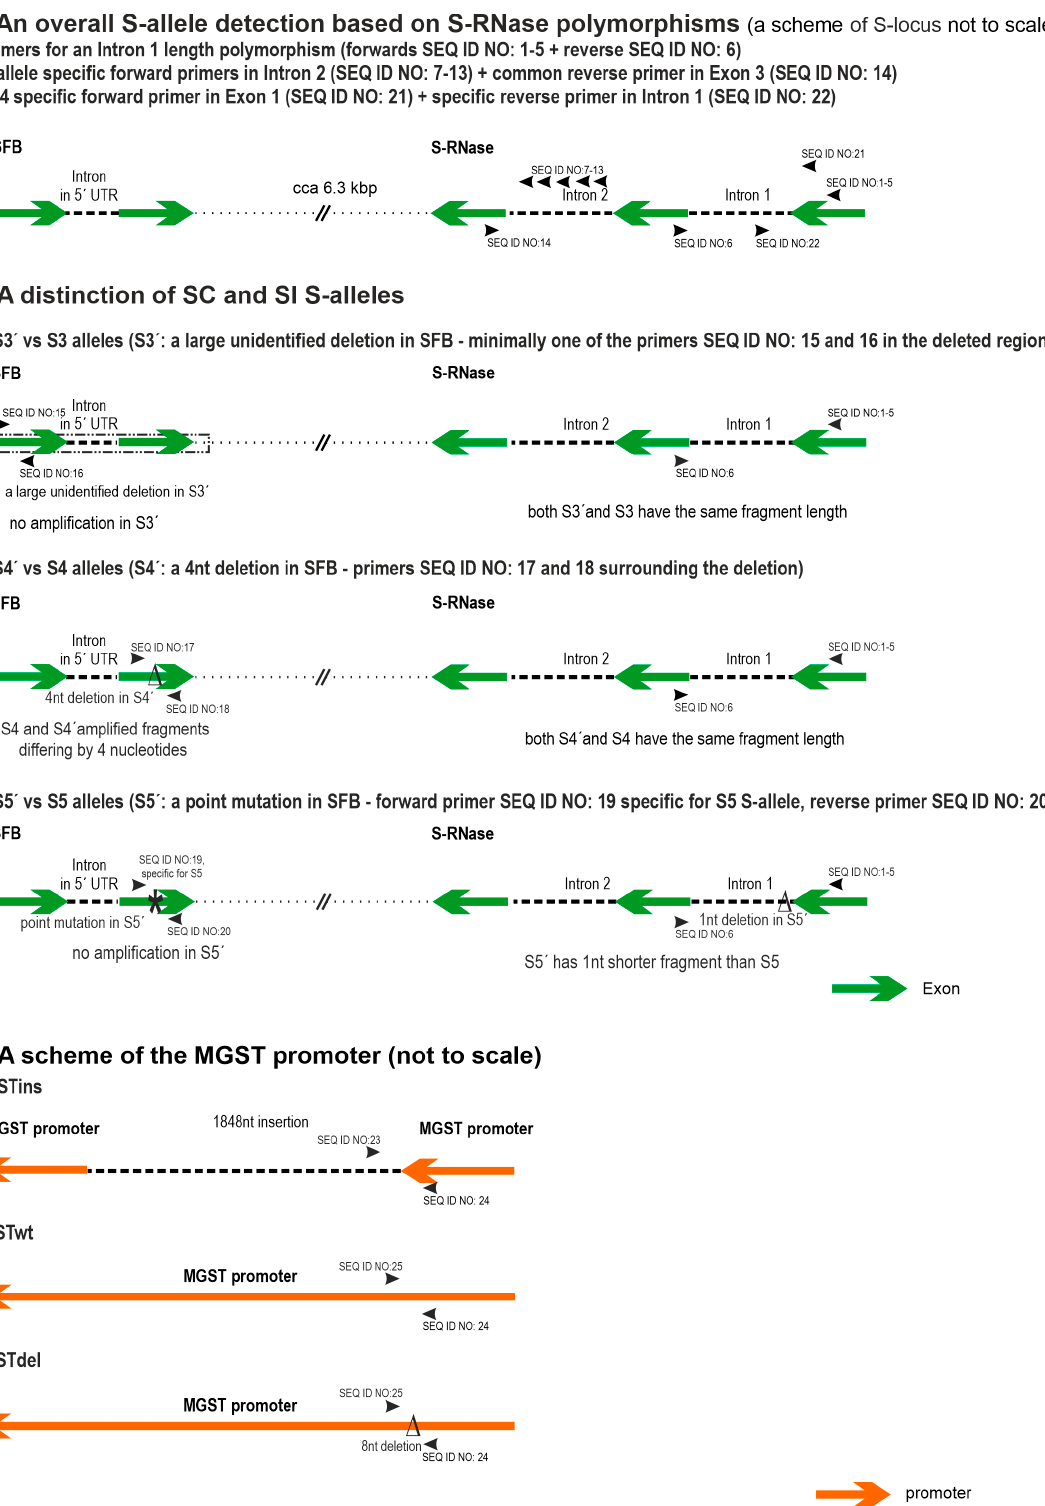
Figure 1. The design of the assay for self-(in)compatibility determination in sweet cherries. The figure is divided into three parts showing: ( 1 ) overall S-allele detection, ( 2 ) discrimination of SC and SI S-alleles, and ( 3 ) MGST allele determination. Drawings based on the ‘Satonishiki’ cultivar reference sequence, BioProject No.